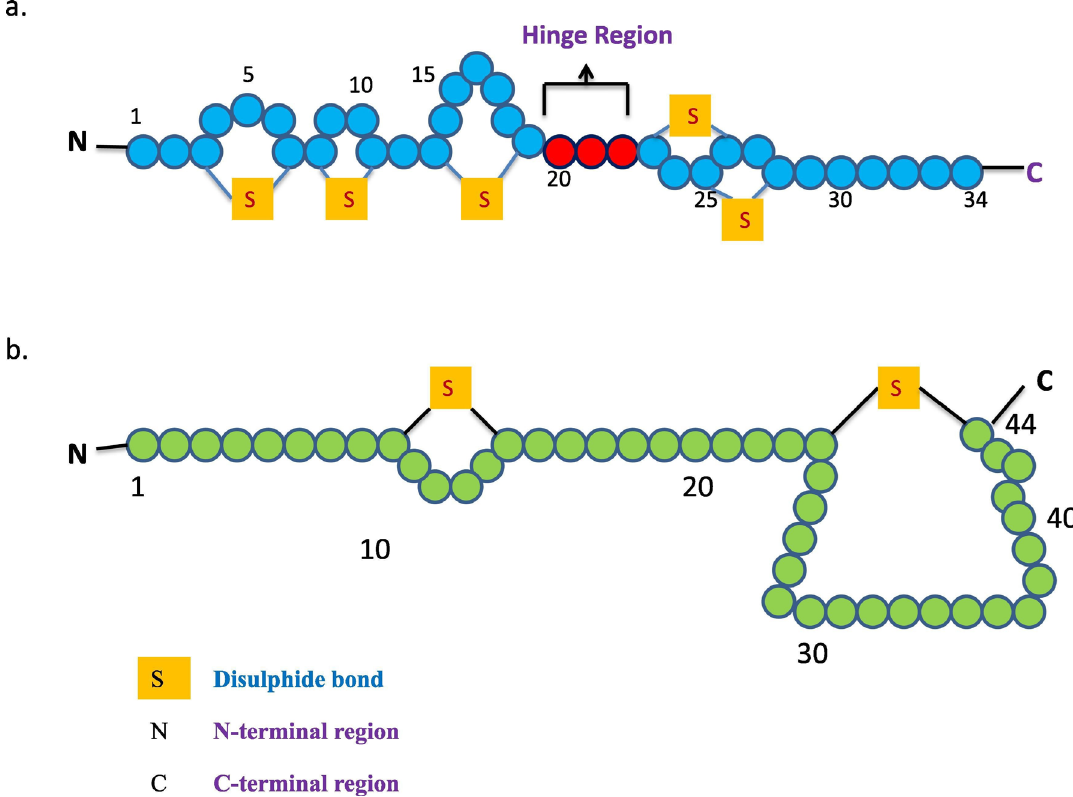
Figure 1. Primary structure of ( a ) nisin and ( b ) pediocin divided into N-terminal and C-terminal. Reproduced with. permission from Ref. [16], copyright 2019, Elsevier.